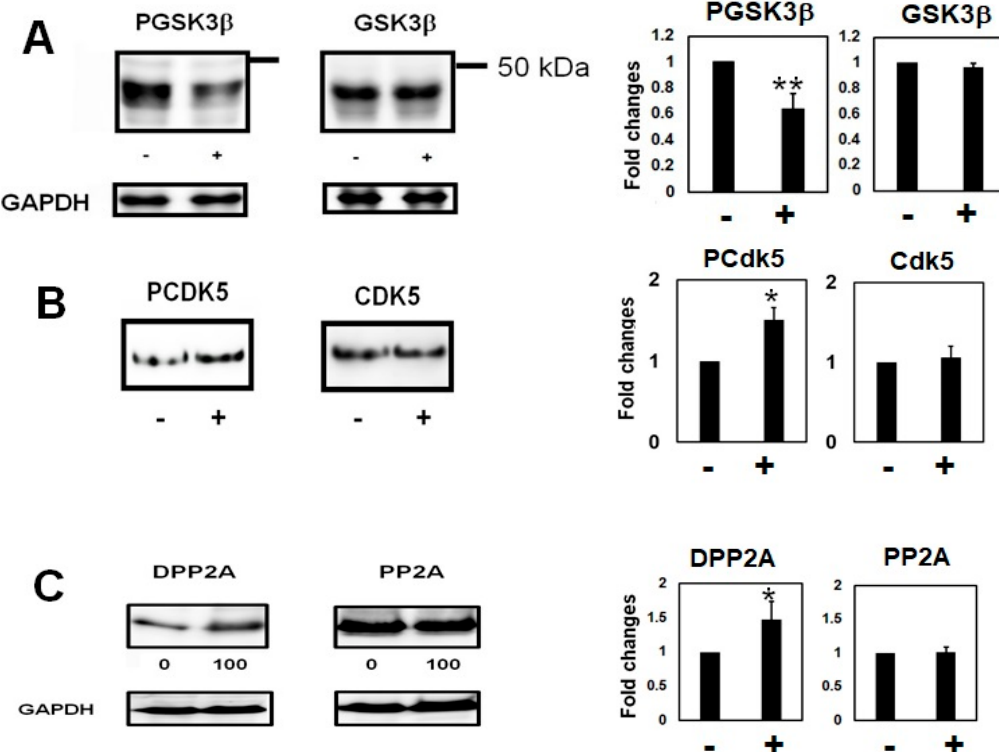
Figure 4. Homocysteine (Hcy) increased GSK3 β activity and decreased PP2A activity in M1C cells. ( A ) Hcy activated glycogen synthase kinase 3 β (GSK3 β ). Hcy treatment decreased phospho-S9 GSK3 β